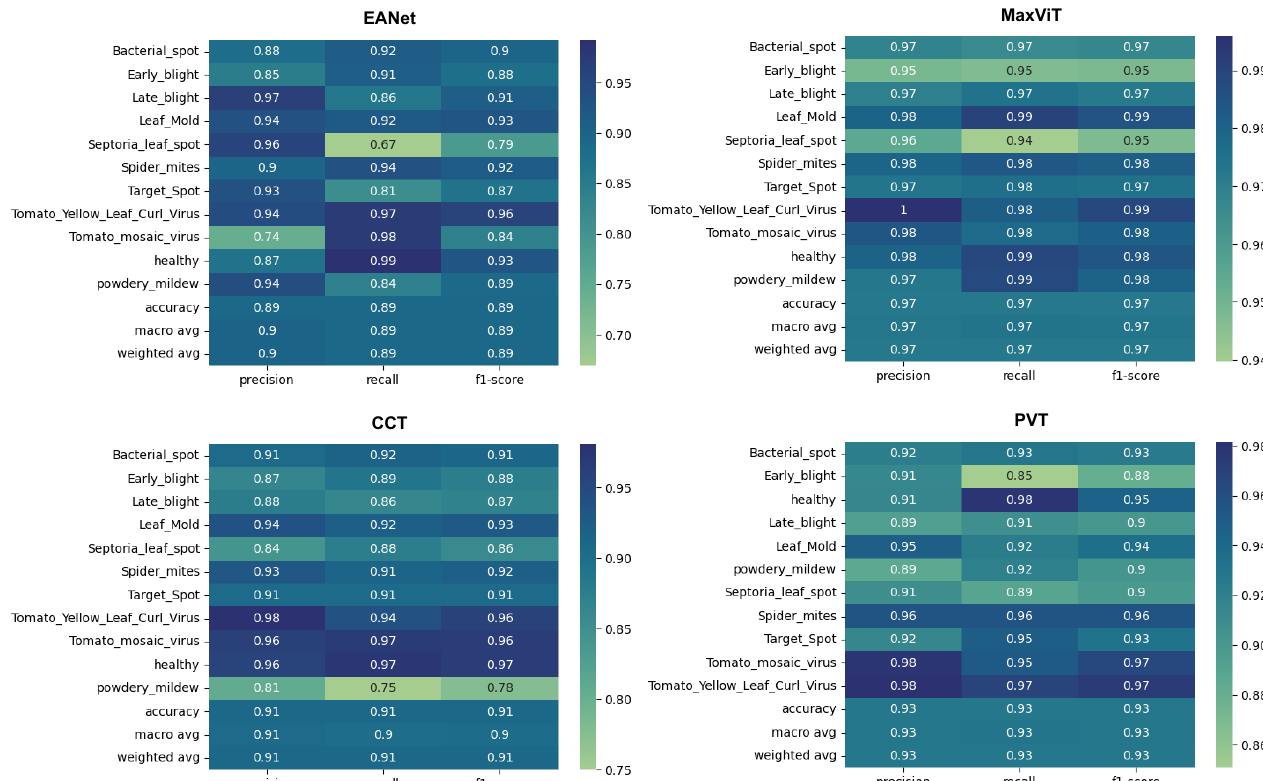
Figure 9. Accuracy and loss curves for the models.